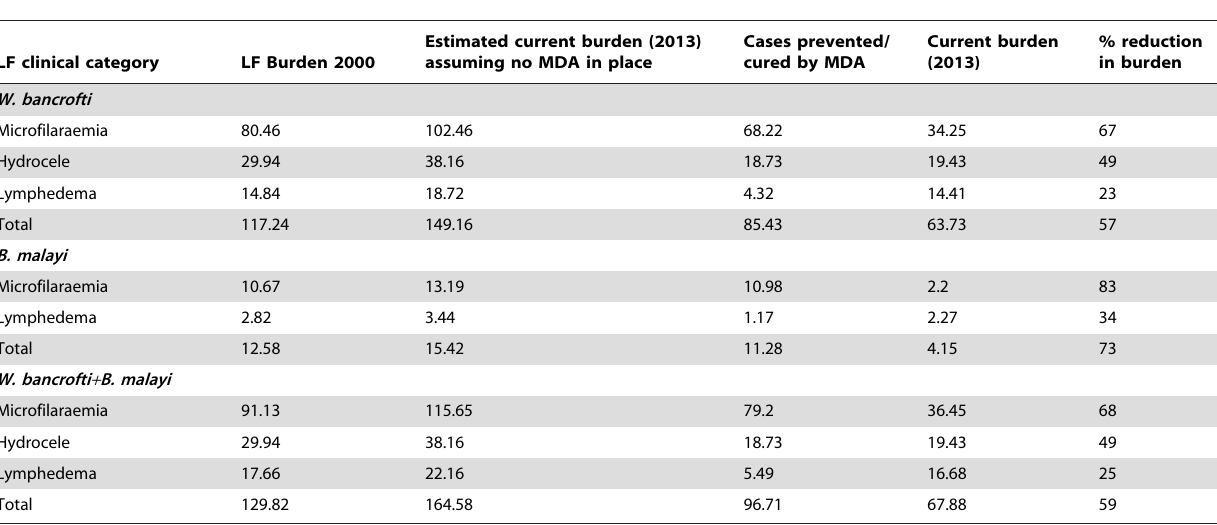
Table 4. Estimated number of different categories of LF cases prevented by the MDA programme under GPELF and current